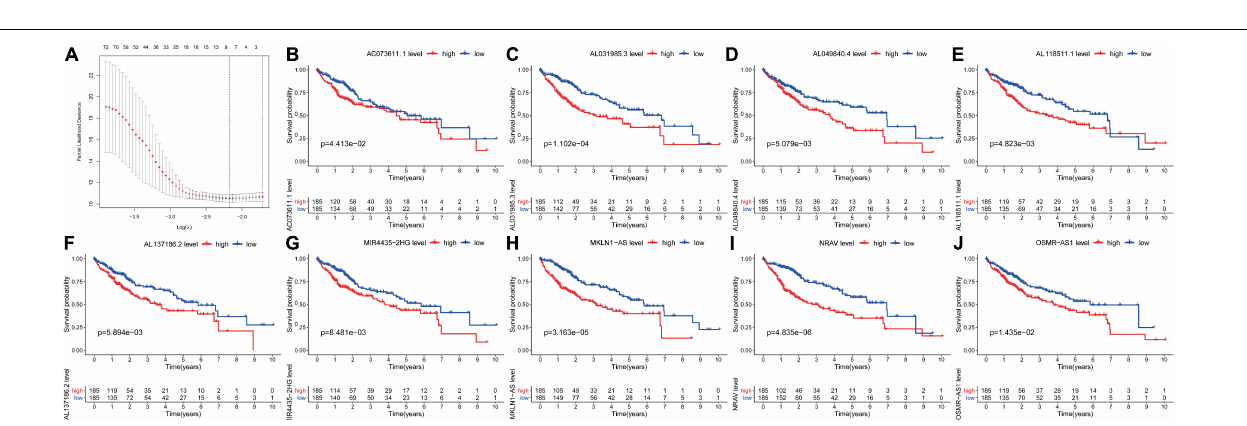
FIGURE 4 | Kaplan–Meier curve analysis of the prognostic pyroptosis-related lncRNAs in TCGA-HCC. (A) Nine differently expressed lncRNAs were selected as independent prognosis factors based on lasso regression. (B–J) The cohort was divided into two groups (high and low risk) based on the median risk score, which was used as the cutoff value, and the high expression of the nine lncRNAs indicated a bad prognosis.